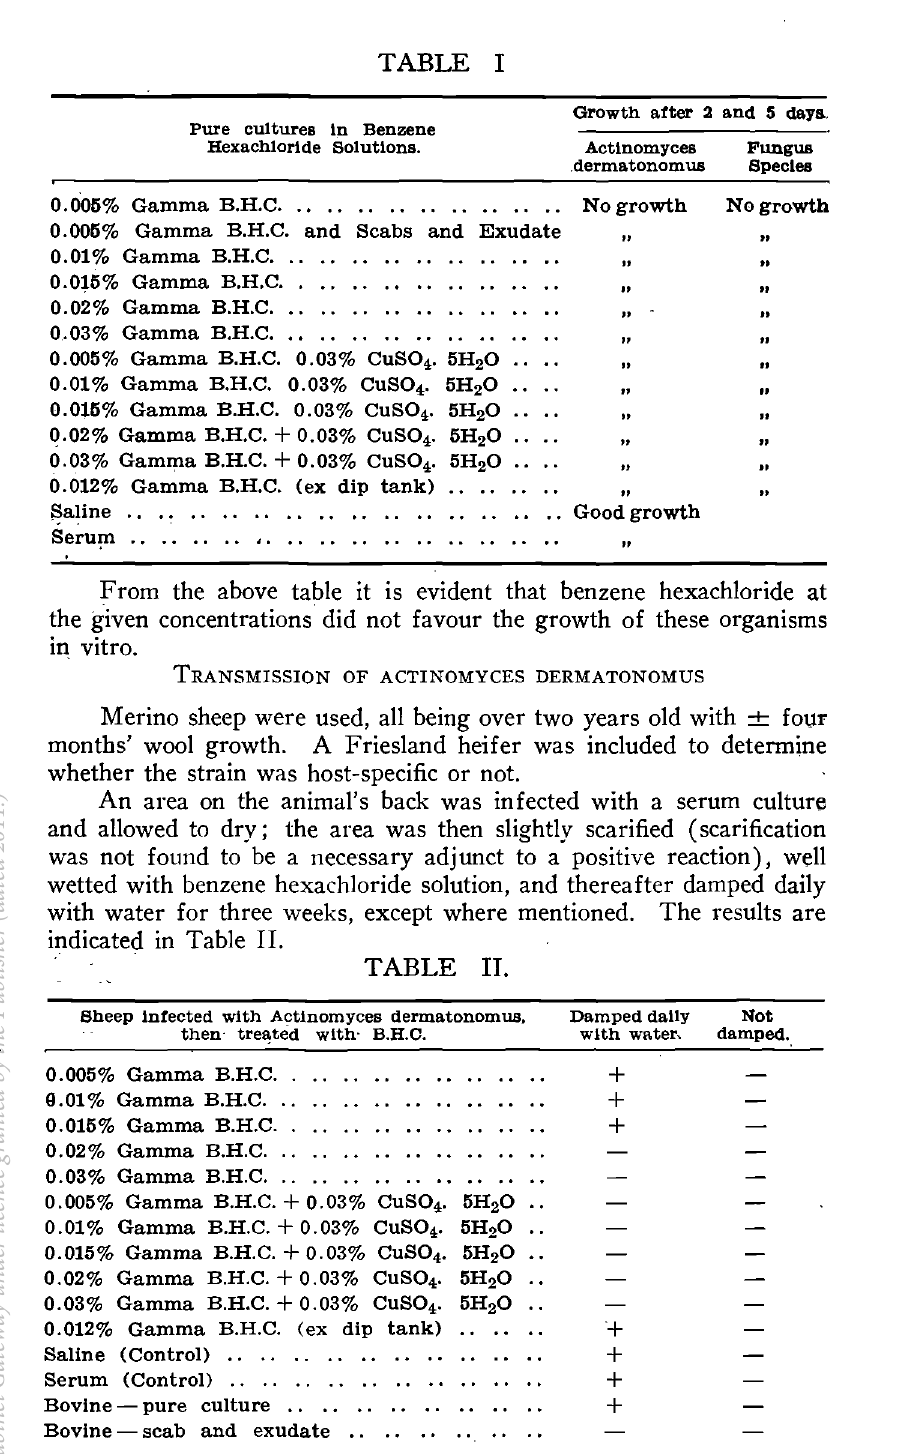
I Growth after 2 and 5 daya.